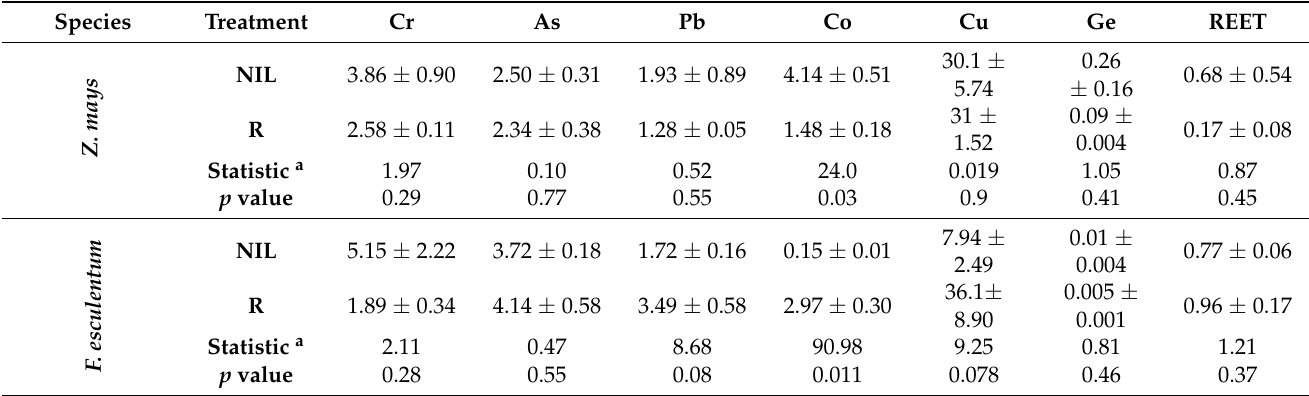
Table 2. Effect of soil inoculation on concentration ( µ g/g) of PTEs, Ge, and REET in shoots of test plant species.